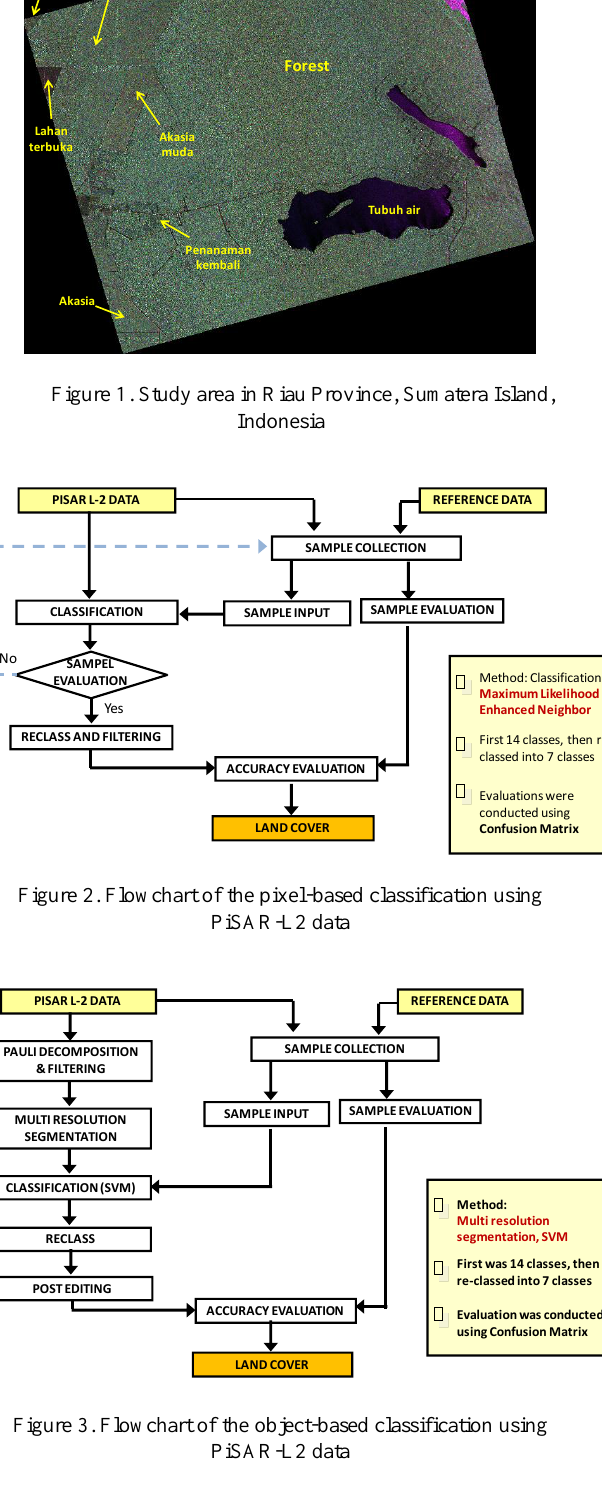
Figure 3. Flowchart of the object-based classification using PiSAR-L2 data Training samples were collected for 14 classes based on land cover map in 2009 produced by WWF and field survey data collected by REDD and JAXA team in 2012. The traning samples were used as input samples in classification